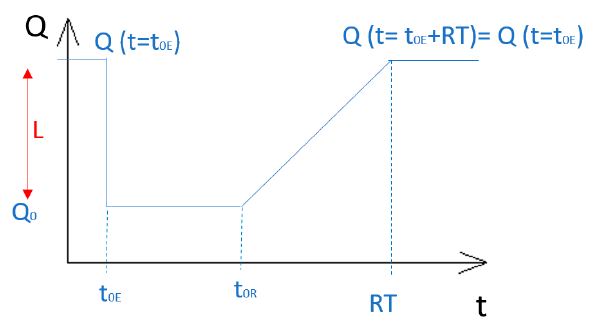
Figure 1. Calculation of SR.